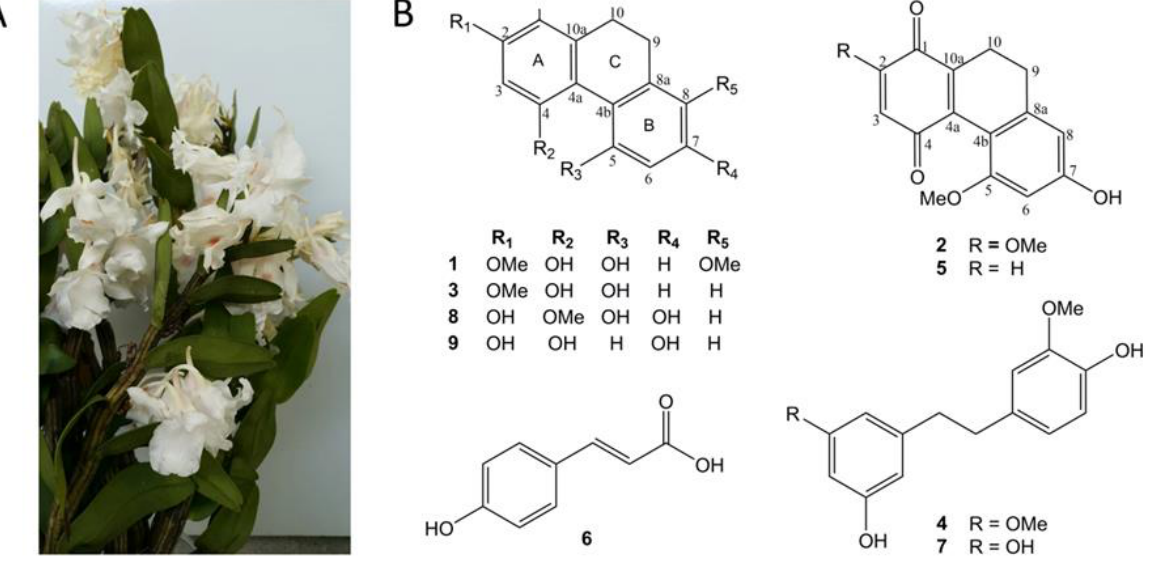
Figure 1. ( A ) Dendrobium virgineum ( B ) Chemical structures of compounds ( 1 – 9